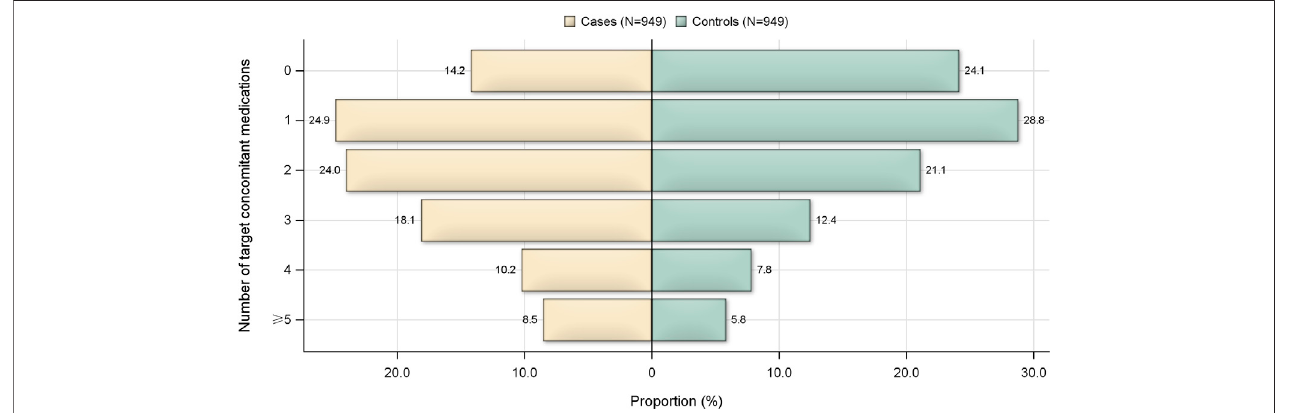
FIGURE 2 | Number of target concomitant medications used by patients in the case and control groups.